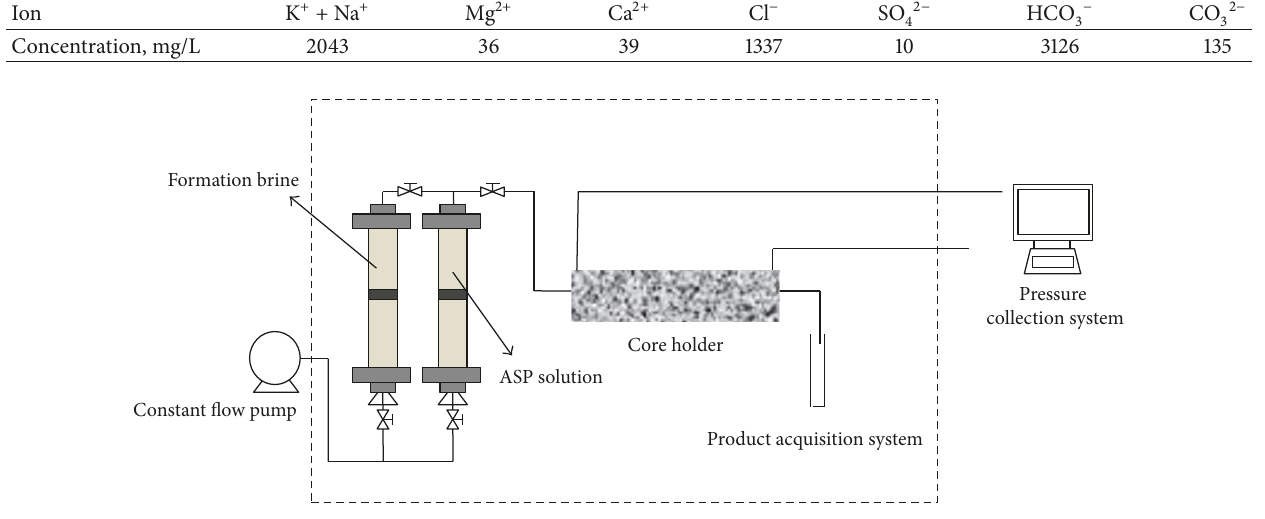
Table 2: Composition of formation brine.